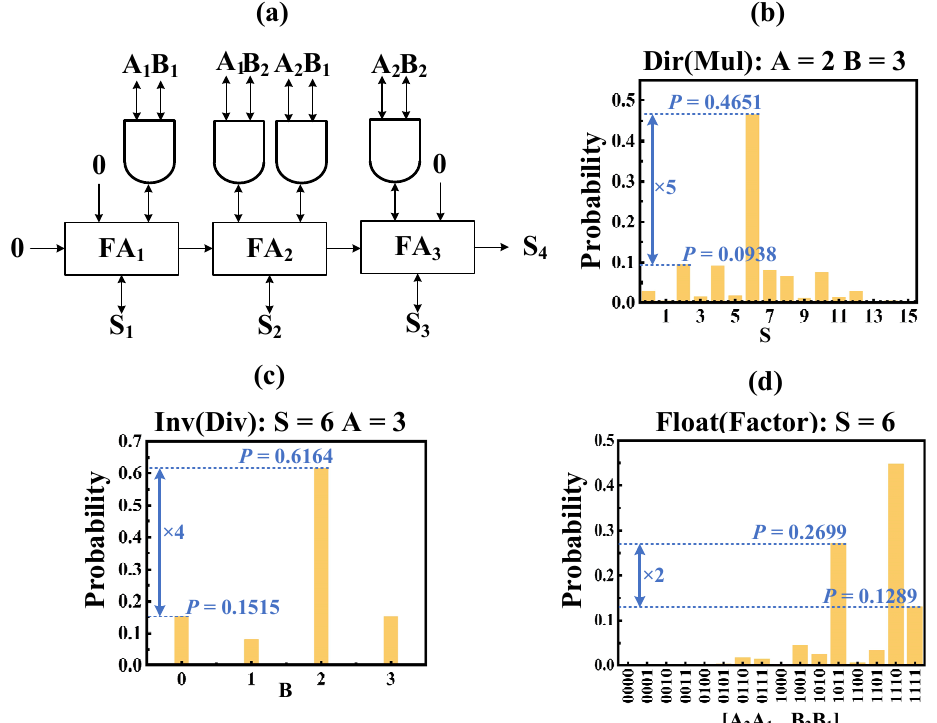
Figure 9. Invertible 4-bit multiplier operation. ( a ) The structure of 4-bit multiplier based on invertible AND gates and FA; ( b ) multiplication: Clamping A = 2, B = 3, the statistics of S; ( c ) division: Clamping A = 2, S = 6, the statistics of B; ( d ) factorization: Clamping S = 6, the statistics of A and B.